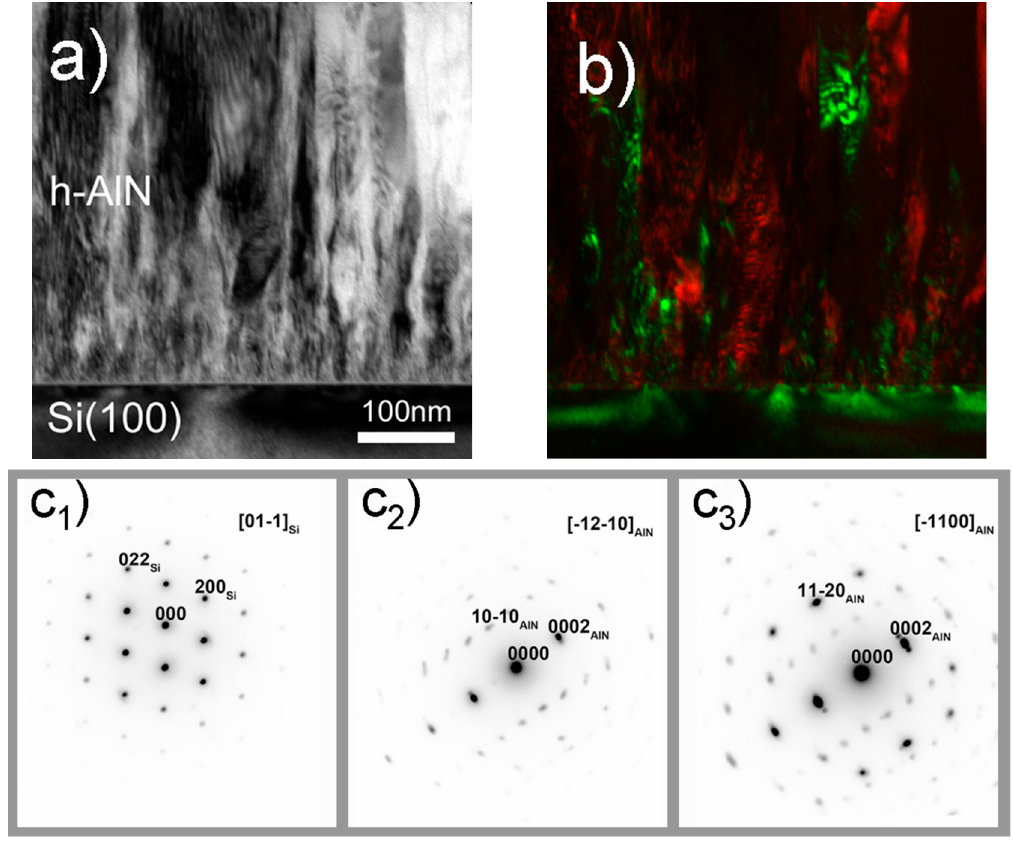
Figure 6. Bright-field ( a ) and dark-field ( b ) cross-sectional TEM images of the PLD AlN film deposited in vacuum (10 − 4 Pa) at a temperature of 800 °C, laser fluence of 10 J/cm 2 , and LPF of 3 Hz. In ( c ), the corresponding selected area electron diffraction (SAED) patterns from (a) are shown: SAED pattern of the Si(100) substrate ( c ₁ ) and SAED patterns of AlN films ( c ₂ , c ₃ ) taken from two possible epitaxially-oriented areas.